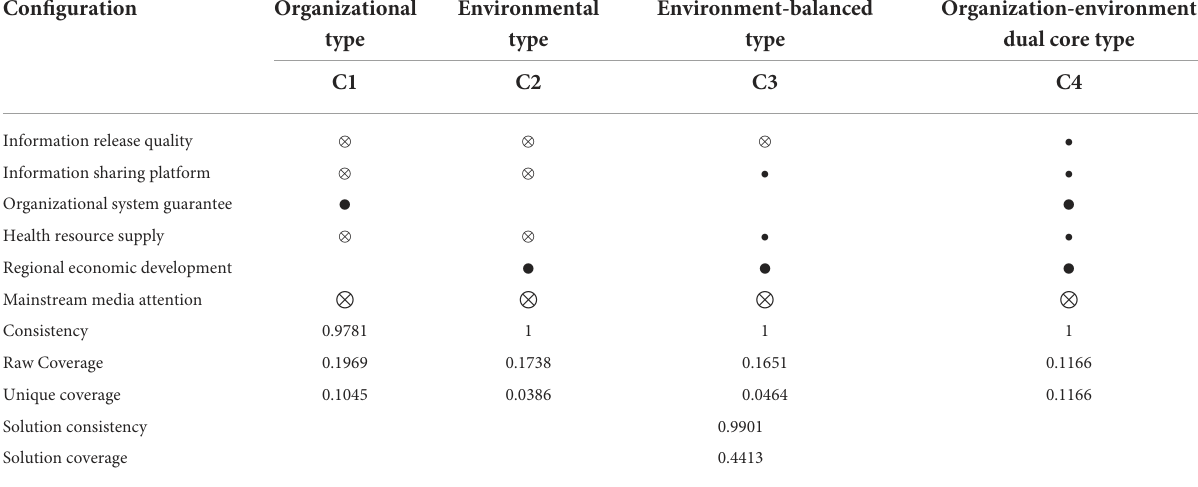
Fullblackcirclesandcrossed-outcirclesindicatethepresenceandtheabsenceofcausalconditions,respectively.Largecircles( (cid:8) and N )indicatethecoreconditions,smallcircles( • and ⊗